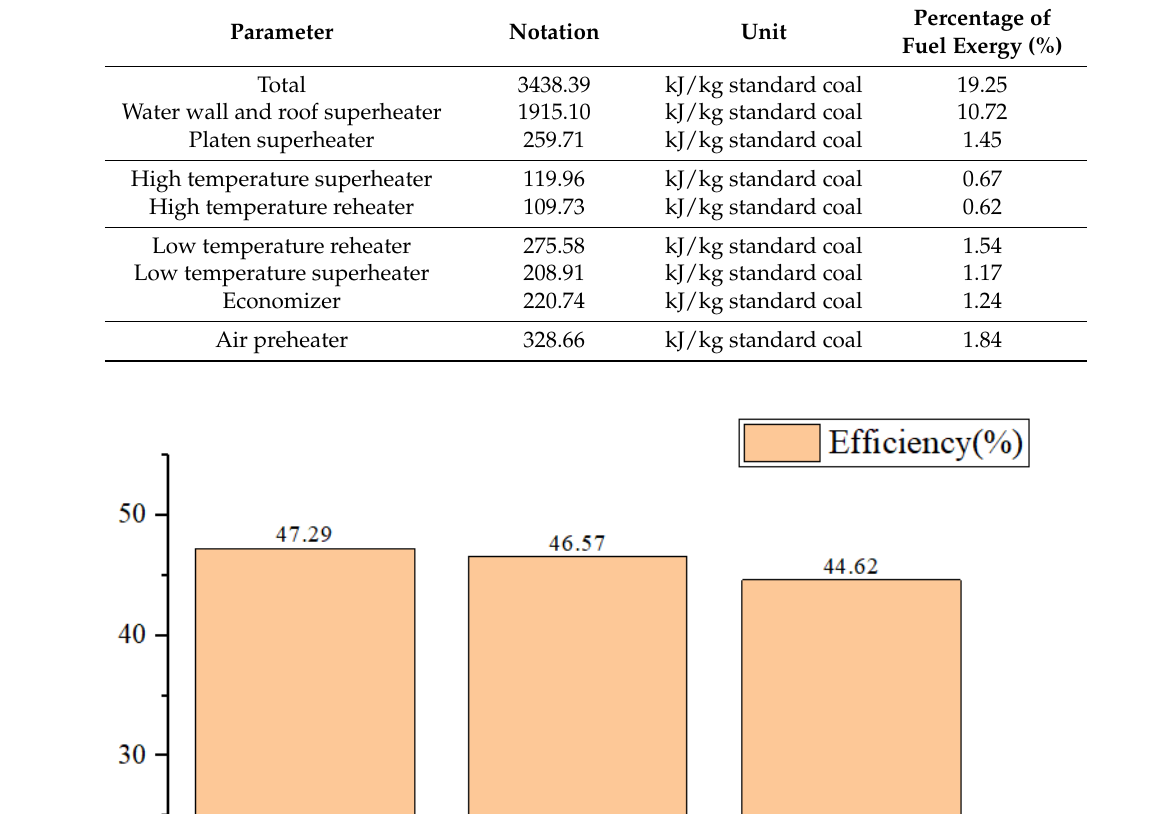
Table 10. Distribution of heat transfer exergy loss of boiler under 50% BMCR load.